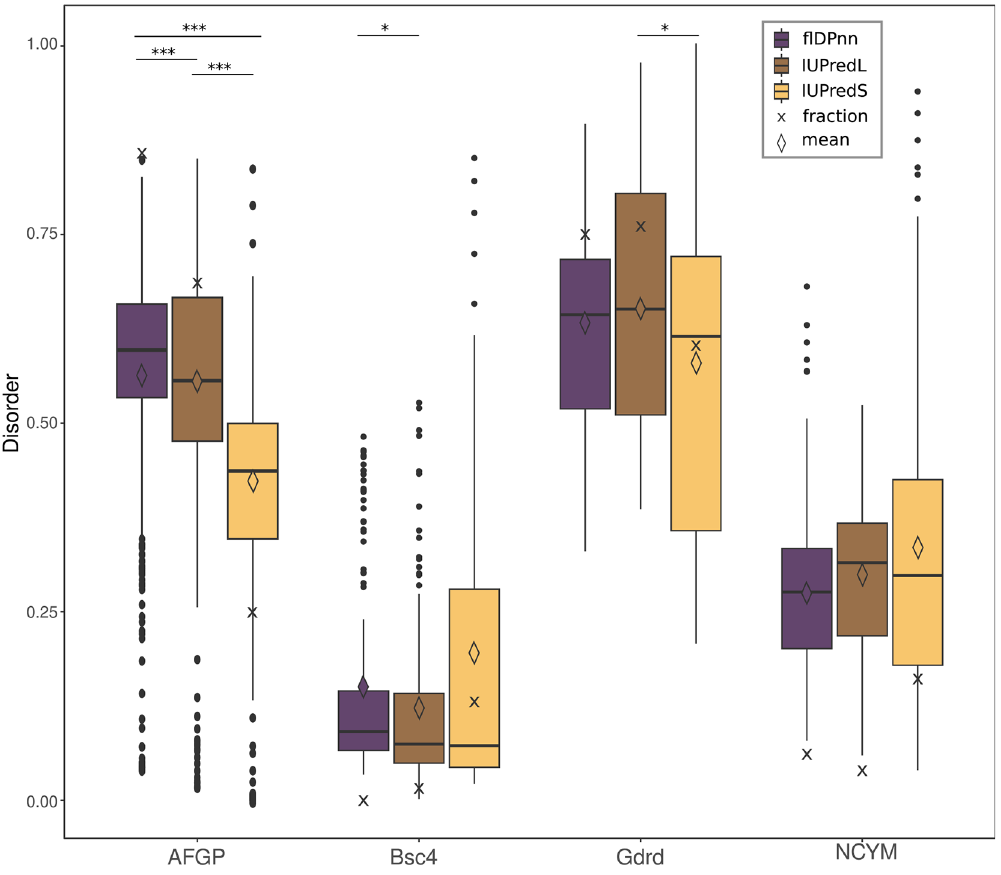
Figure 1. Comparison of different disorder predictions for de novo proteins: The predictors flDPnn and IUPred long (L) and short (S) have been used for disorder predictions of the four de novo genes AFGP, Bsc4, Goddard (Gdrd)andNCYM. Meanvaluesaredisplayedasdiamondshapes,medianaslinesandcrossesdisplaythefractionof disordered residues. Significant differences between the disorder predictors are indicated by stars (***<0.0005; **<0.005;